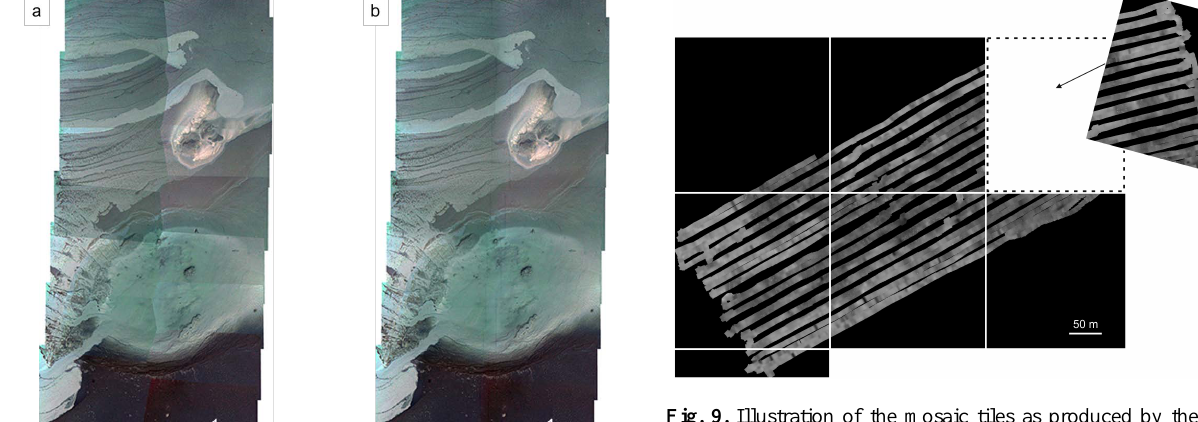
Fig. 9. Illustration of the mosaic tiles as produced by the LAPM tool; in this example, each square tile contains 10000 × 10000 pix- els and covers about 50000m 2 . Individual tiles are constructed sep- arately in order not to exceed the computing resources; tiles are geo-referenced, hence, loading them into a GIS allows displaying the photo-mosaic entirely. The photo-mosaic contains 5421 images and covers a 105000m 2 -large area of the Regab pockmark (Lower Congo